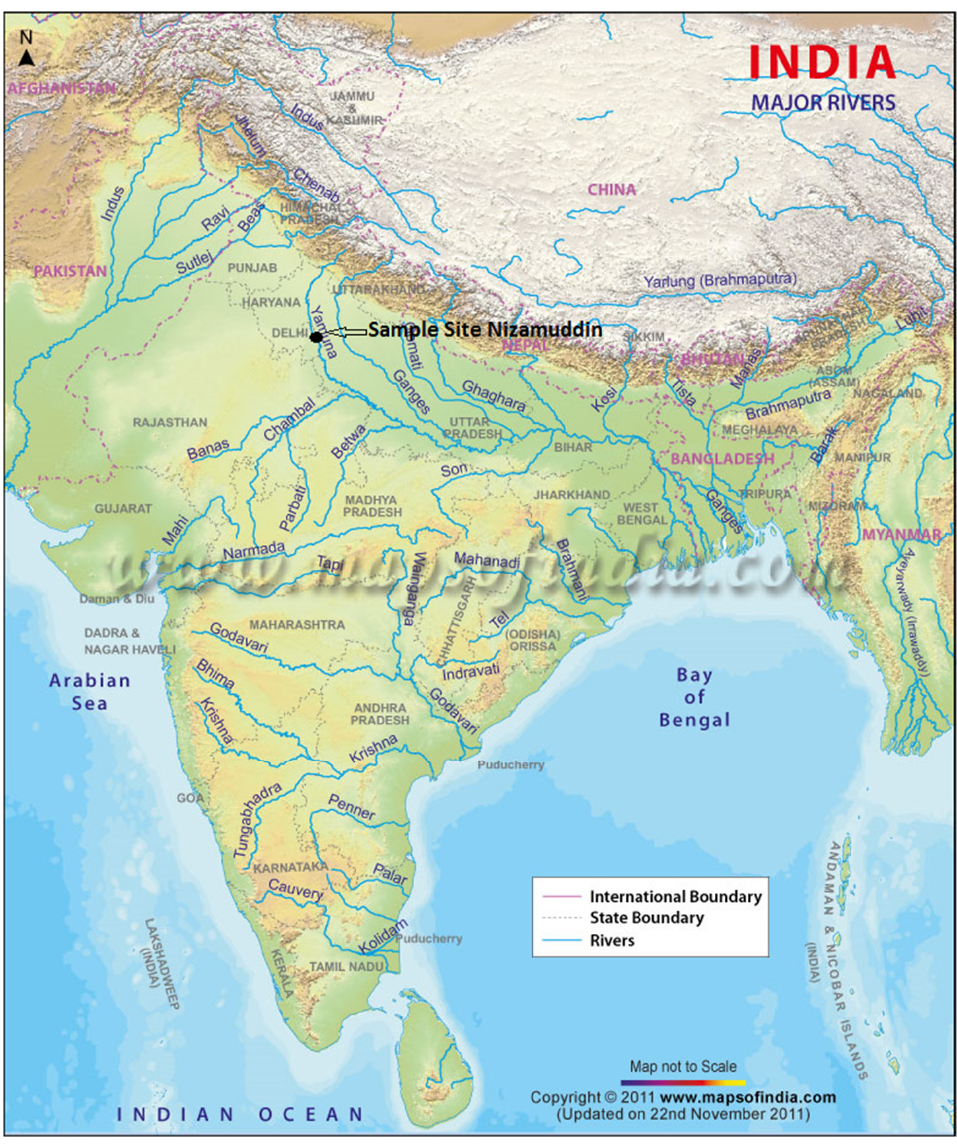
Figure 1. Sampling site at Nizamuddin in Delhi. Table 1. The monthly statistics of COD at the sampling site in Delhi during different periods (Kisi and Parmar, [21]).